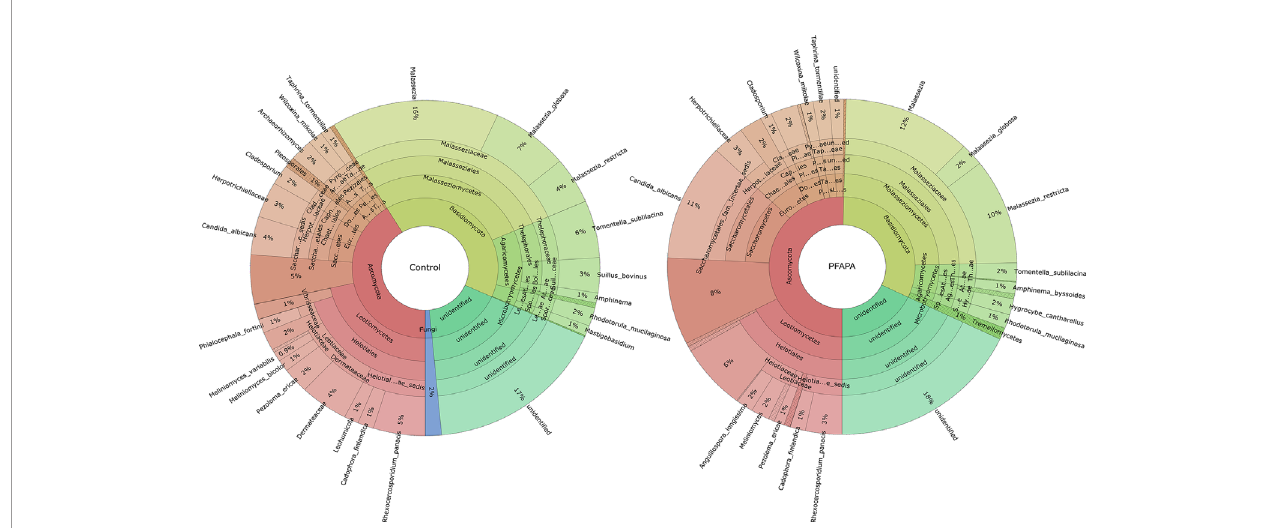
FIGURE 1 | The relative abundance of fungal mycobiome community in 52 tonsil tissue samples [30 pharyngitis and adenitis syndrome (PFAPA) and 22 controls]. Less abundant (<0.5 %) genera are not shown or are